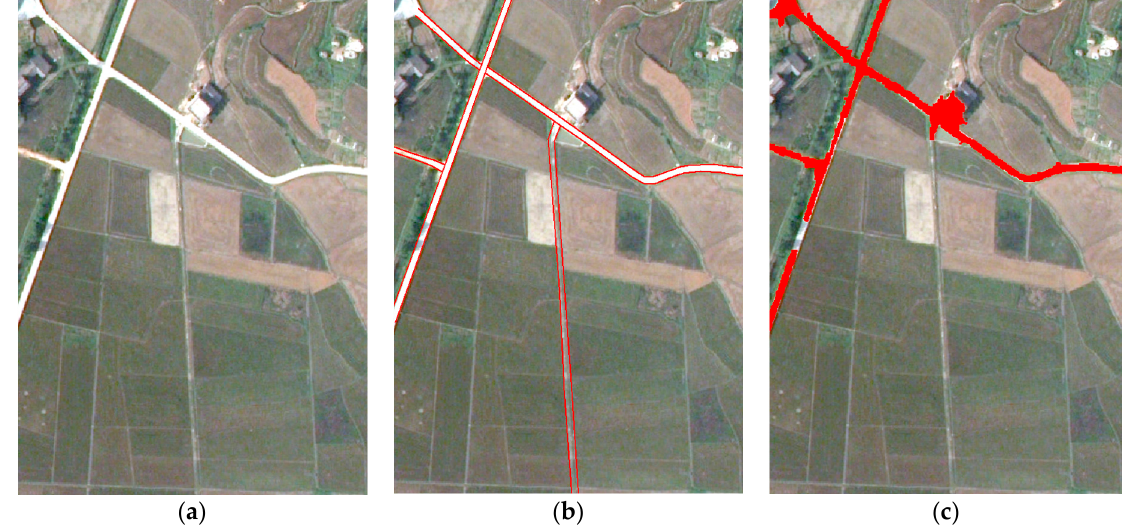
Figure 19. Comparison of GFI and OOC result in region 2: ( a ) remote sensing image, ( b ) GFI result, ( c ) OOC result.